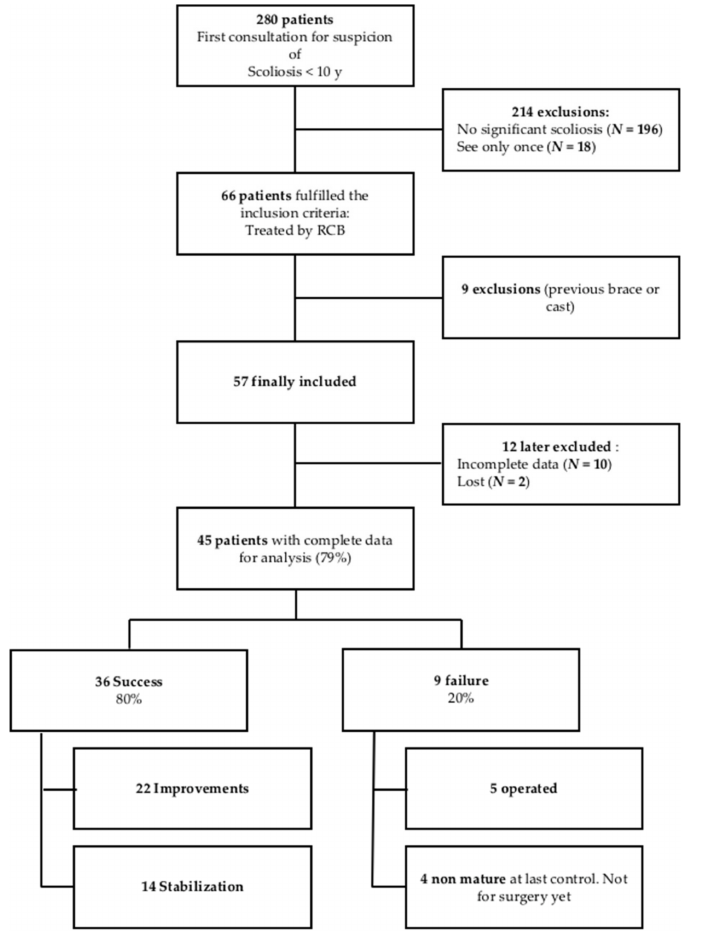
Figure 3. Flow chart. Worst case analysis = 63.2% success (36 success/57 finally included, presuming that cases lost to follow had